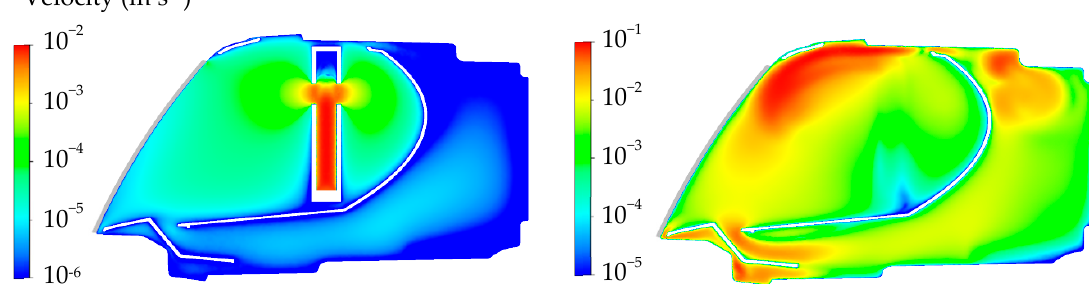
Figure 8. Velocity distribution inside the headlamp in case C2—cross section through the humidifier. ( left ) Simulation of fogging (preparative stage—20 min since the beginning of humidification); ( right ) simulation of defogging (evaluated stage—30 min since the beginning of defogging).